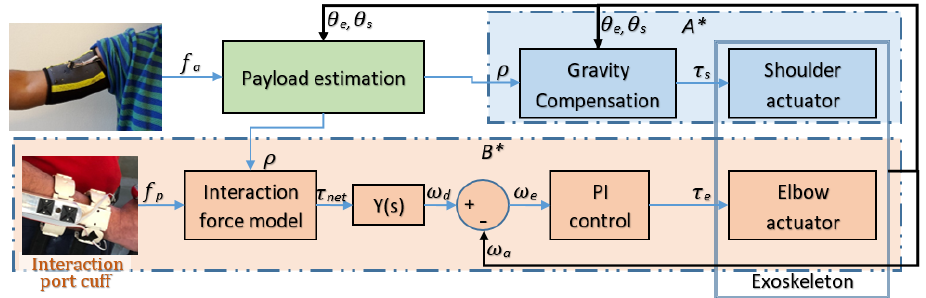
Figure 10: Exoskeleton control block diagram, where A* and B* are two blocks for control of shoulder and elbow joint, respectively.